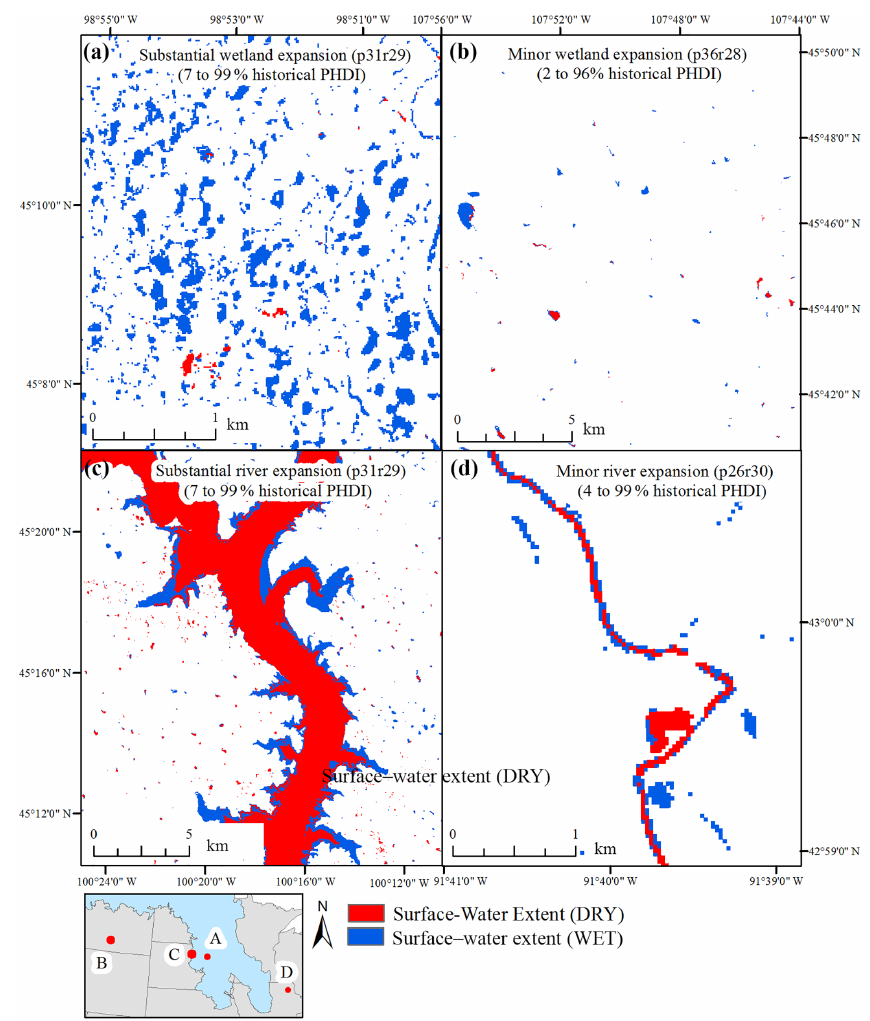
Figure 5. Examples of minor and substantial expansion of surface water extent between historically dry and historically wet points in time. PHDI – Palmer Hydrological Drought